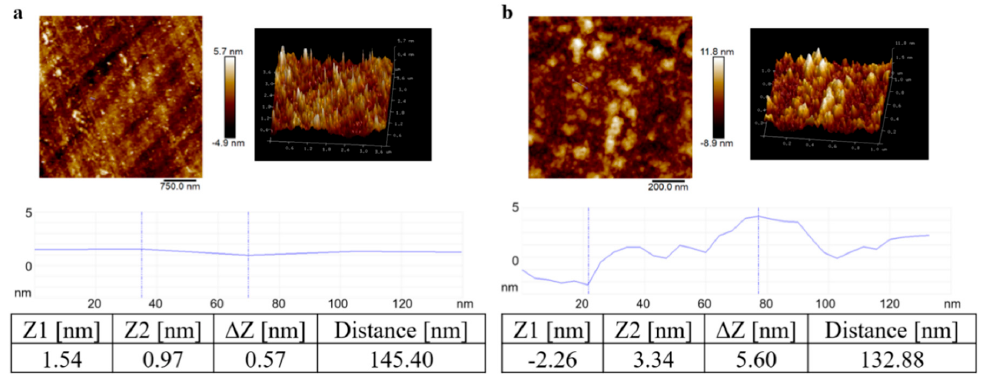
Figure 3. AFM topography images of chips. ( a ) Bare and ( b ) 3-succinyl-CBF-OVA conjugate-modified waveguide chips (higher right); 3-D AFM topography image (higher right) and variations in cross-section heights taken at a rough area (lower: position indicated by blue line in the topographic images).